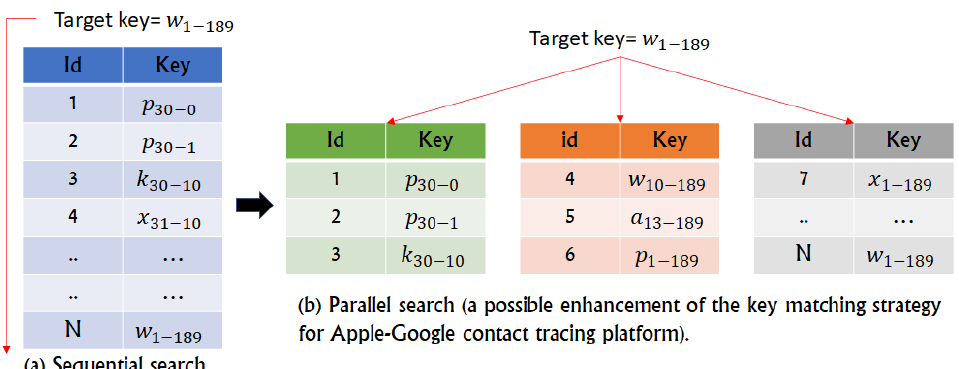
Figure 10. A conceptual overview of enhancement in the key matching method of Apple–Google contact tracing platform: ( a ) checking the possibility of target key match with stored keys in a sequential form (e.g., one by one), ( b ) checking the possibility of target key match with stored keys in a parallel form (e.g., more than one at a